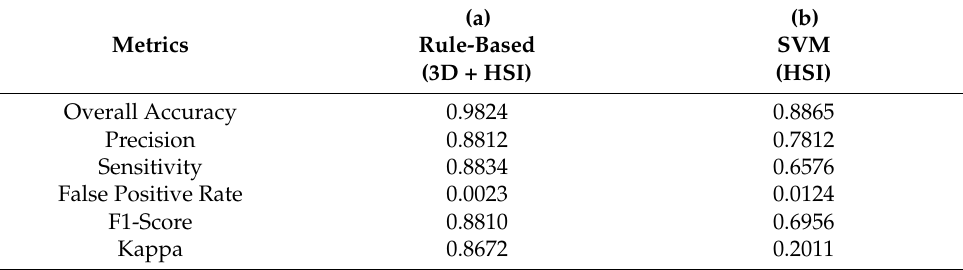
Table 2. Classification accuracies for real electronic wastes using ( a ) Rule-based approach with combined 3D and HSI dataset; ( b ) SVM classification (C-SVC, RBF-Kernel, C: 2048, gamma: 2.8284) with HSI